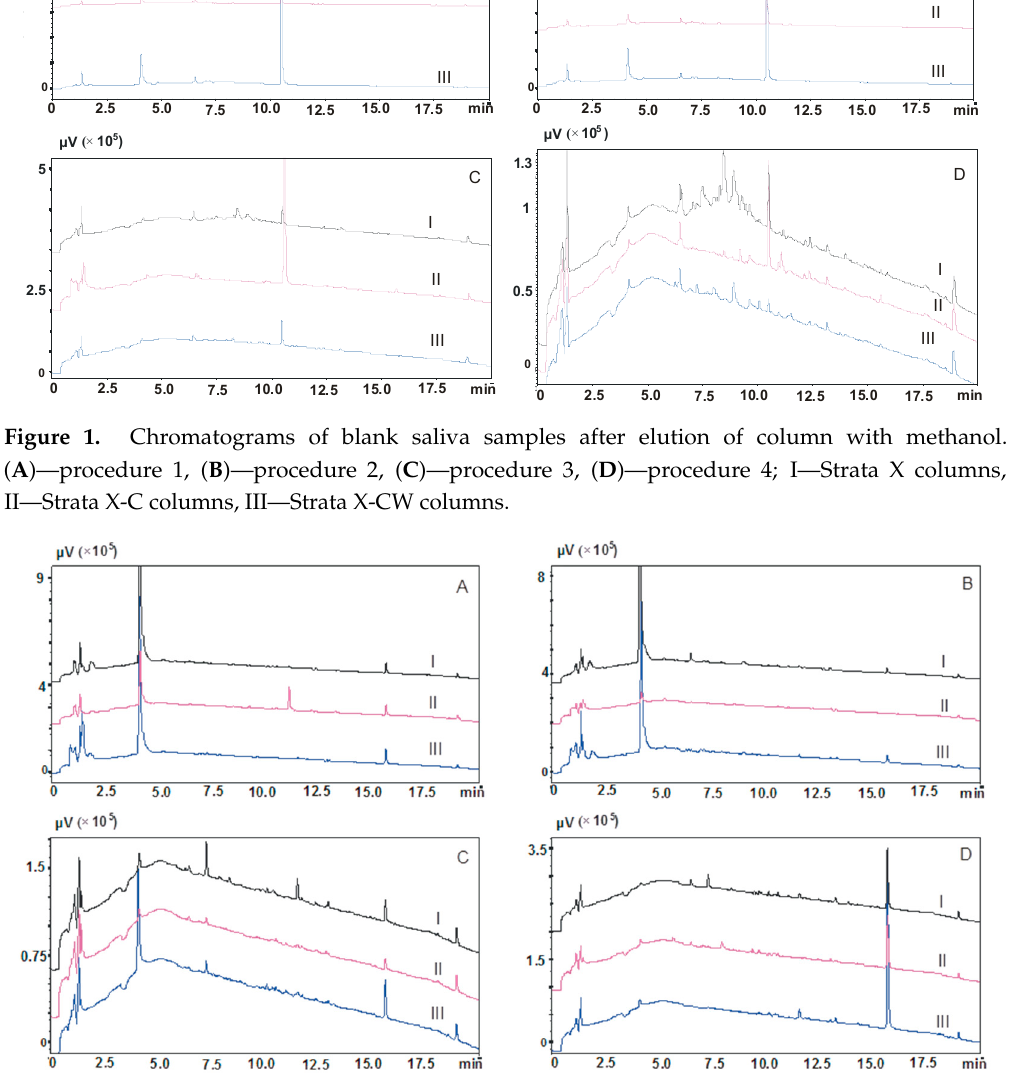
Figure 2. Chromatograms of blank saliva samples after elution of column with acetonitrile. ( A )—procedure 5, ( B )—procedure 6, ( C )—procedure 7, ( D )—procedure 8; I—Strata X columns, II—Strata X-C columns, III—Strata X-CW columns.